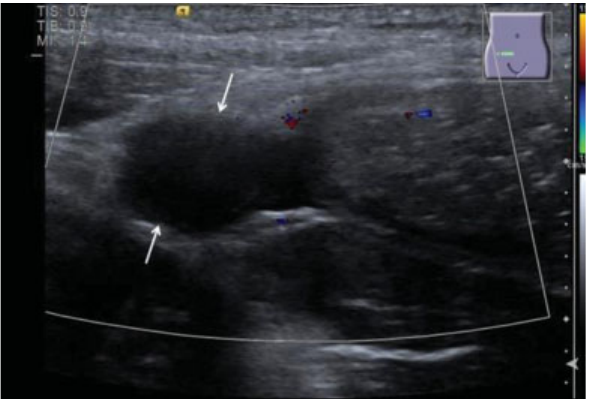
Fig. 2 The thickened appendix shows complete loss of the regular bowel layers, in general is hypoechoic (between arrows). There is no marked hyperperfusion of the